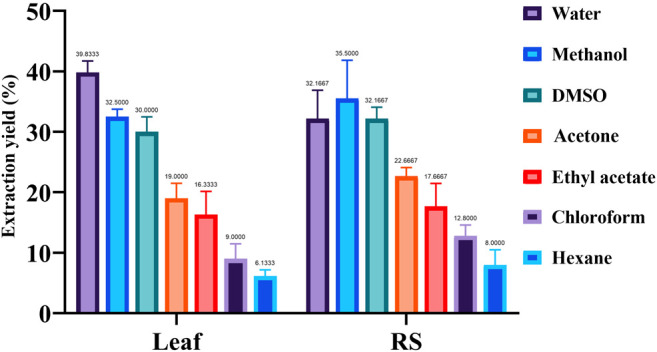
Percent extract recovery of metabolites obtained from Suaeda leaf and root-shoot (RS) samples using different solvents. One-way ANOVA (F 35.08; p < 0.0001; R
2 0.9678) showed significant differences among means (P****) by Turkey’s multiple range test. DMSO, dimethyl sulfoxide.